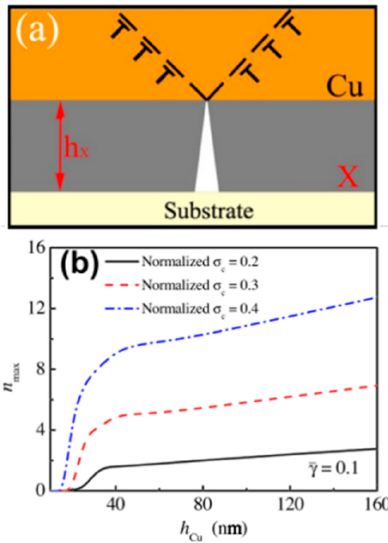
Figure 14. ( a ) Sketch of the micromechanical fracture model in NMMFs; ( b ) Model predicted n max at different normalized cohesive strengths ( σ c ) as a function of h [8].